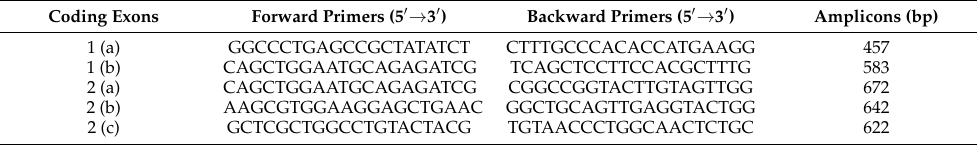
Table 3. Intronic primers to amplify the coding exons and splicing donors/acceptors of the SOX18 gene.